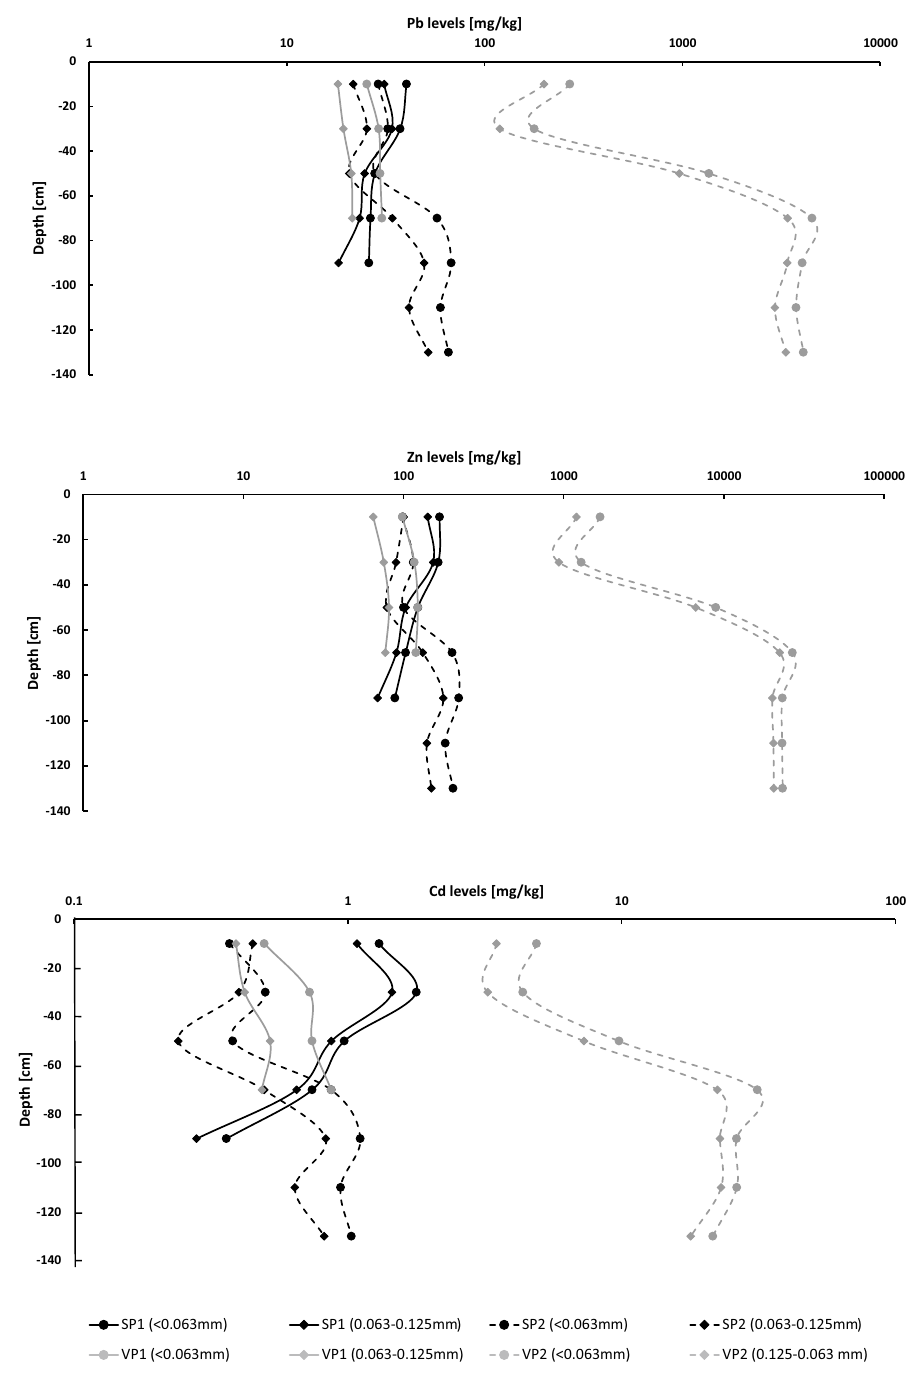
Figure 4. Pb, Zn and Cd levels in alluvial sediment profiles. SP1/SP2 alluvial sediment profile from the Savinja river floodplain above/below Celje, VP1/VP2 alluvial sediment profile from the Voglajna river floodplain above/ below